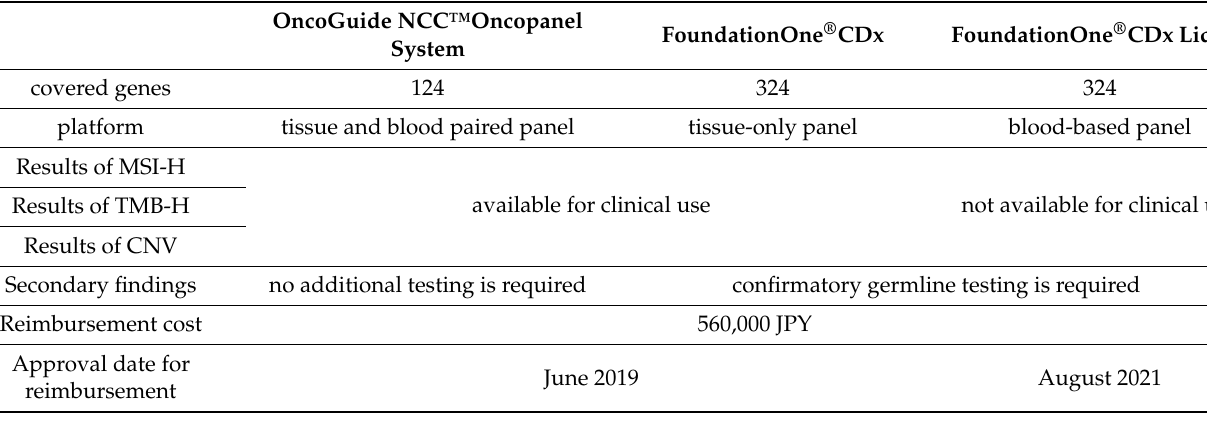
Table 1. Features of three reimbursed CGP panels in